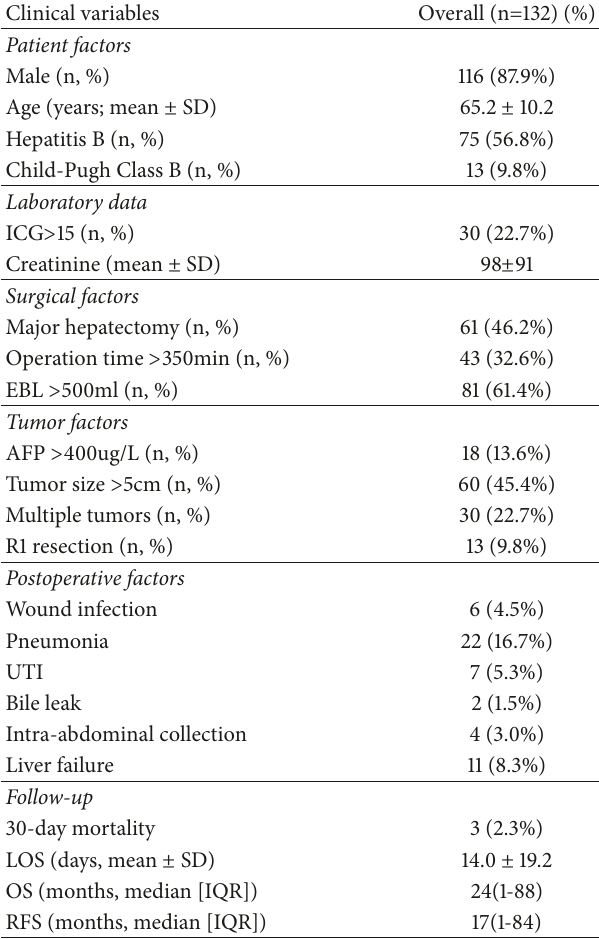
Table 1: Clinicopathological characteristics of patients undergoing curative hepatectomy for